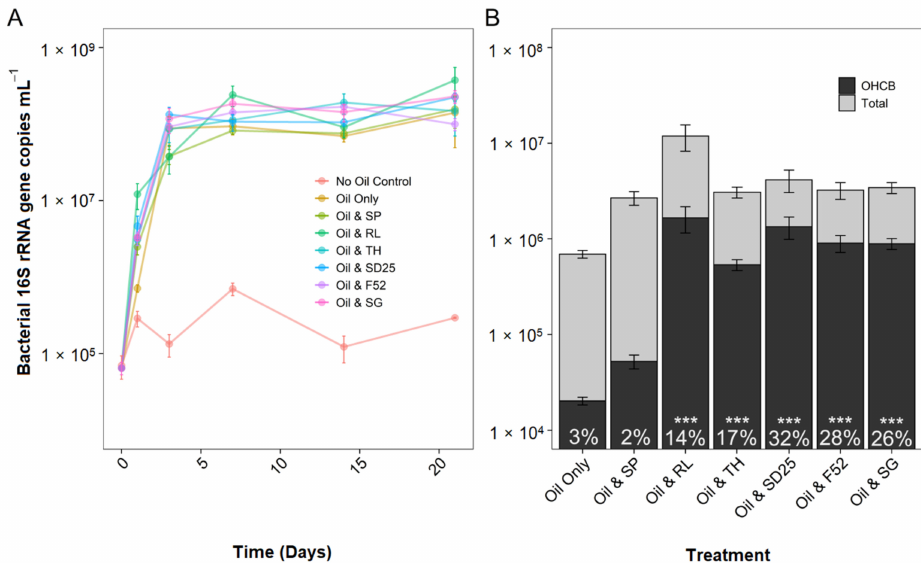
Figure 2. Bacterial 16S rRNA gene abundance (mean ± SE, n = 3) over a 21 day period for total bacteria ( A ) and at day 1 only, for total bacteria and proportion (percentage figures) of obligate hydrocarbonoclastic bacteria ( B ). OHCB sequences are defined as from the genera: Alcanivorax , Cycloclasticus , Oleibacter , Oleispira , Thalassolituus . All microcosms contained seawater, nutrients, and oil (NSO-1 0.1% v / v ), and some also contained additional dispersants or biosurfactants (0.005% v / v ; 20:1 ratio of oil). Dispersant and biosurfactant codes are as follows: SP = sophorolipid, RL = rhamnolipid, TH = trehalolipid, SD25 = Superdispersant 25, F52 = Finasol OSR 52, and SG = Slickgone NS. Asterisks above percentage figures indicate significant differences in mean OHCB relative abundance compared to the oil-only control (*** p <